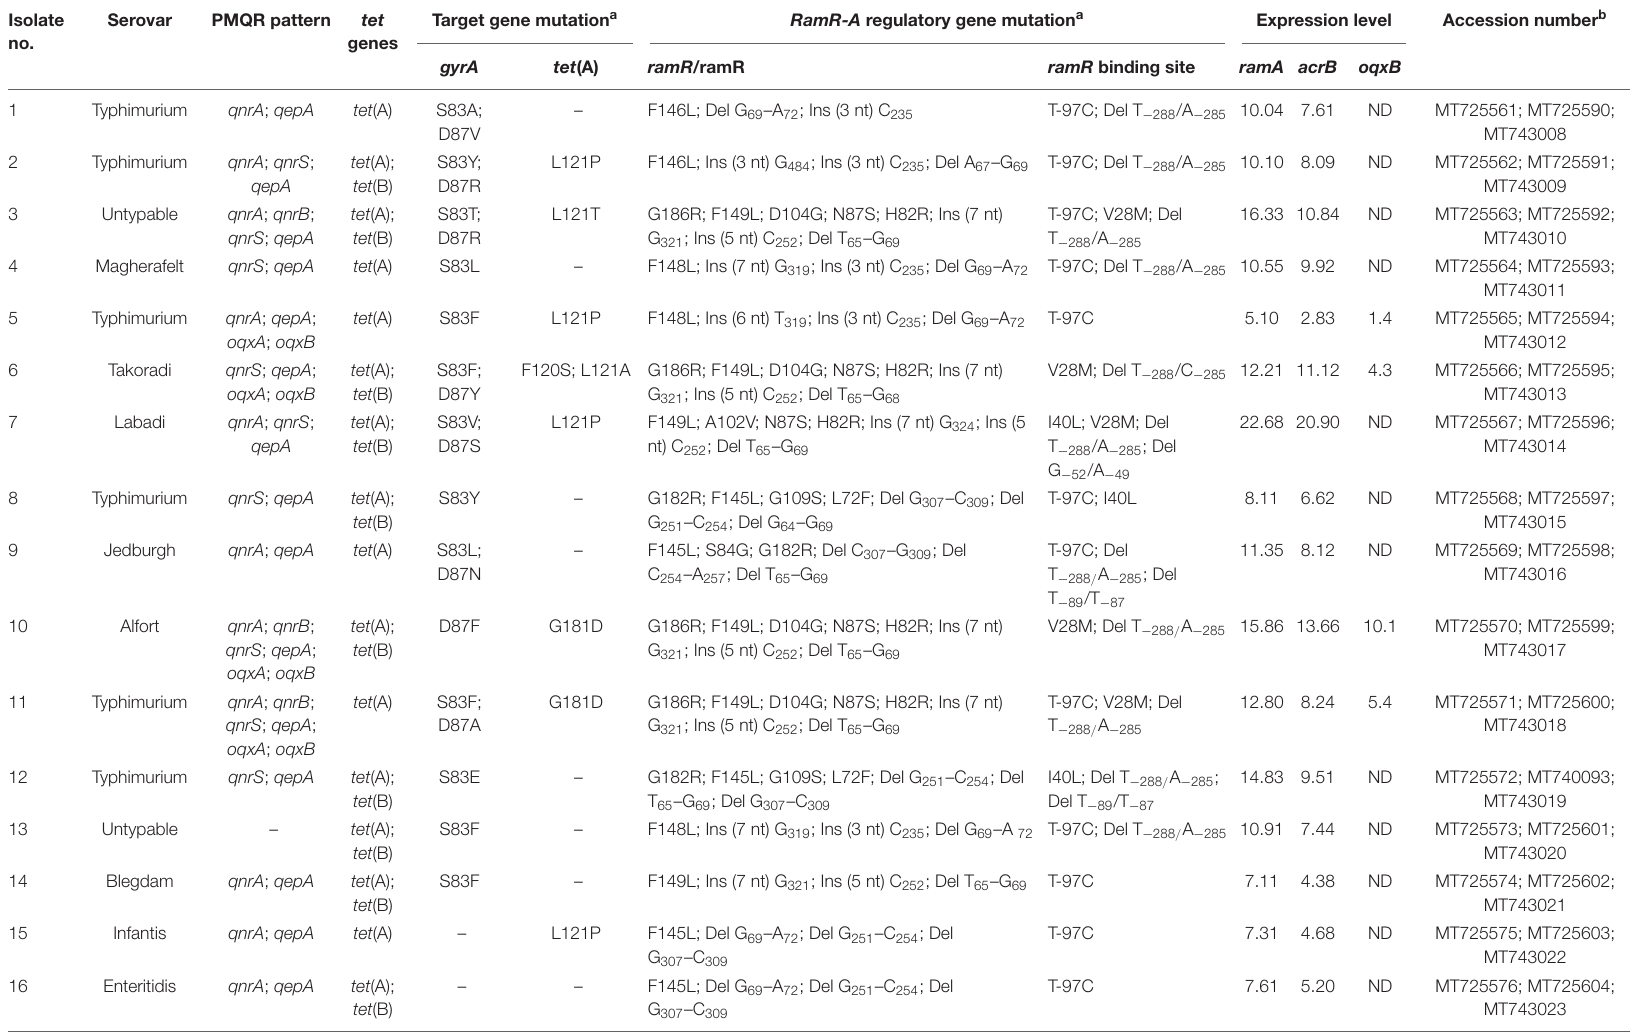
TABLE 3 | Existence of plasmid-mediated quinolone resistance genes, tet genes, mutations in the target [ gyrA , tet (A)] and regulatory ( RamR-A ) genes, and expression of efflux pump genes ( ramA and acrB ) in XDR Salmonella enterica serovars showing ciprofloxacin and/or tigecycline resistance. Isolate